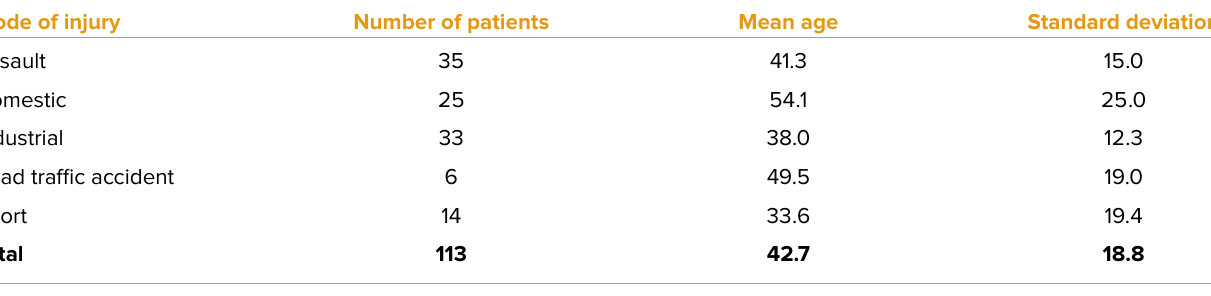
Table 2. Initial pre-op and final post-op visual acuity with overall visual acuity change in different BETTS groups (mean and standard